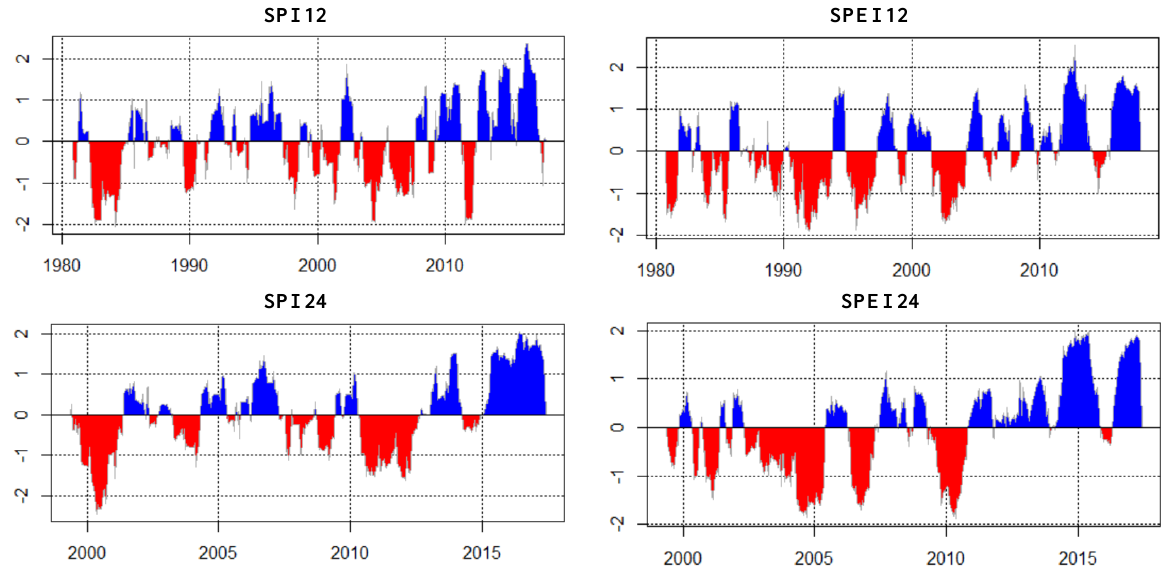
Figure 5. SPI (left) and SPEI (right) 5values for the selected Ziguinchor station in the Casamance basin area, calculated over a 12 and 24 month